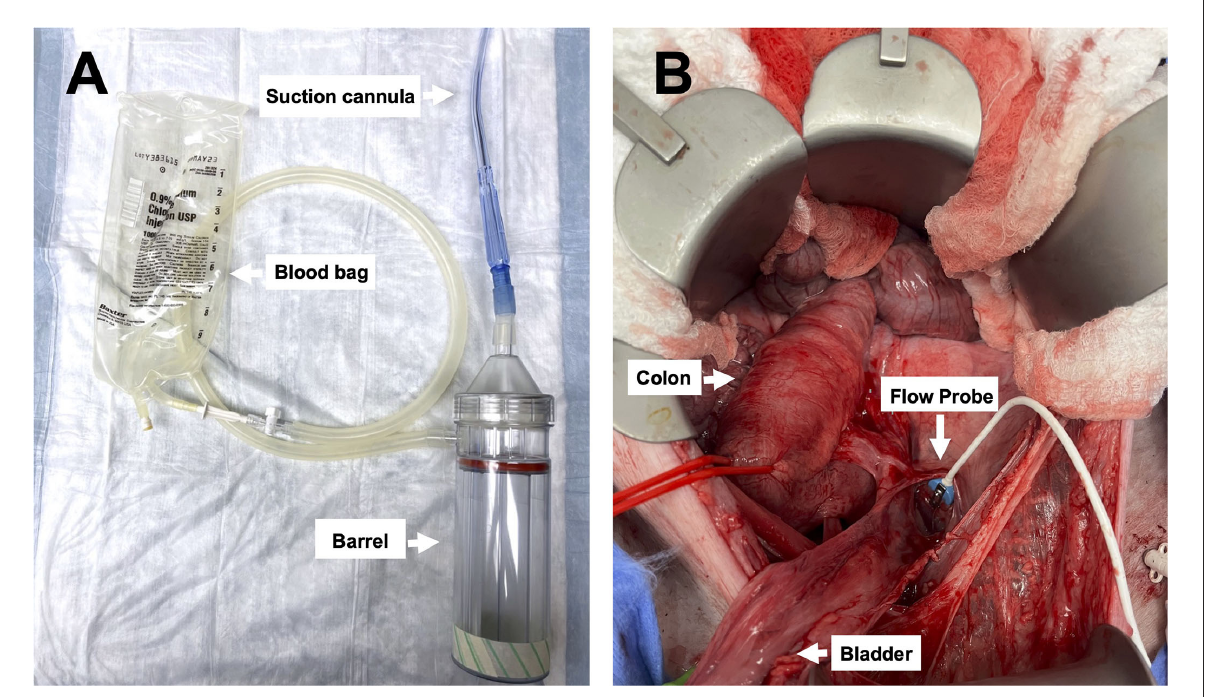
FIGURE2 Images of the device and pelvic exposure: (A) The Hemafuse device (barrel) and the suction cannula are connected to an empty blood bag (i.e., an empty crystalloid 1L bag), and (B) surgical exposure of the pelvic well created for the pelvic hemorrhage model.